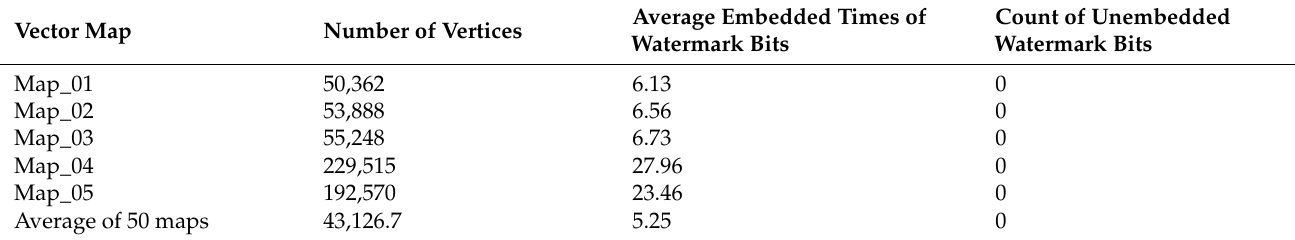
Table 7. Statistical results of watermark